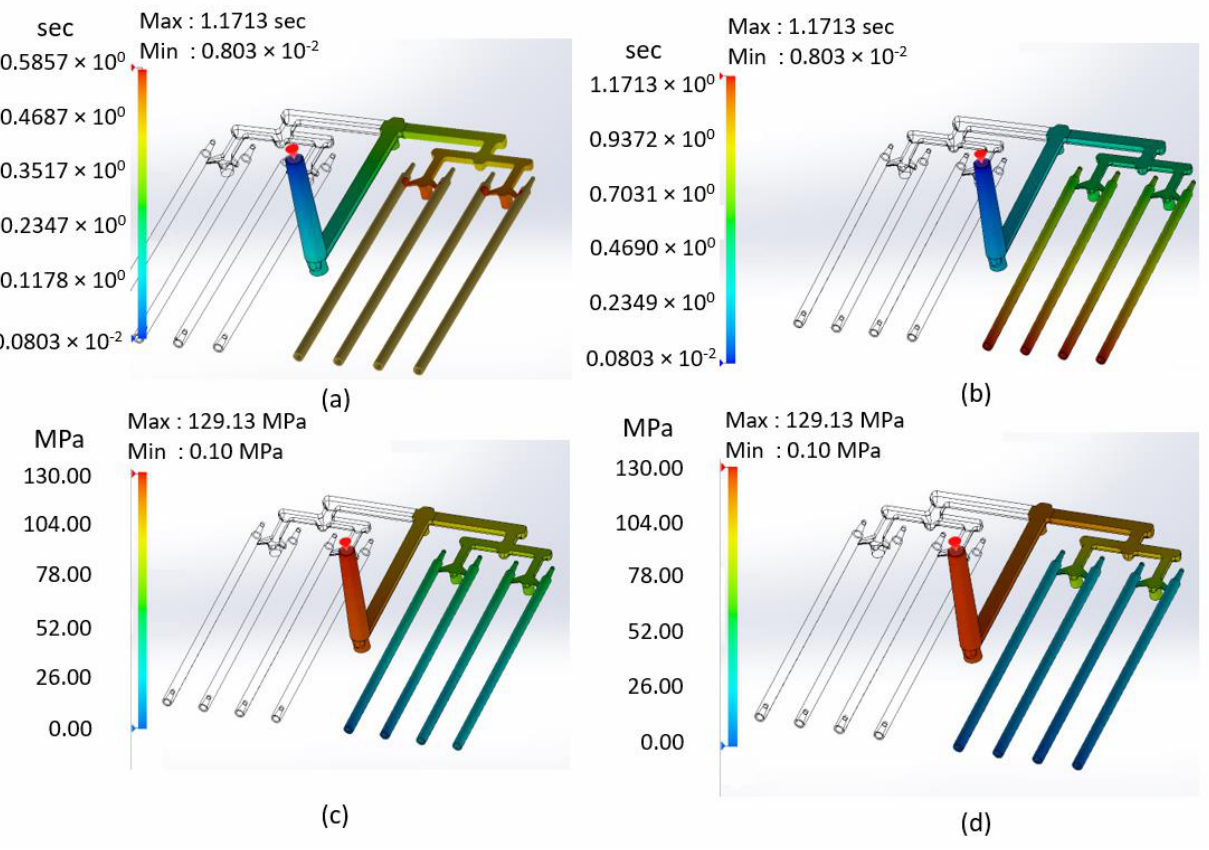
Figure 6. ( a ) Fifty percent of the fill time; ( b ) total fill time; ( c ) pressure at the end of fill; and ( d ) pressure at the end of packing.